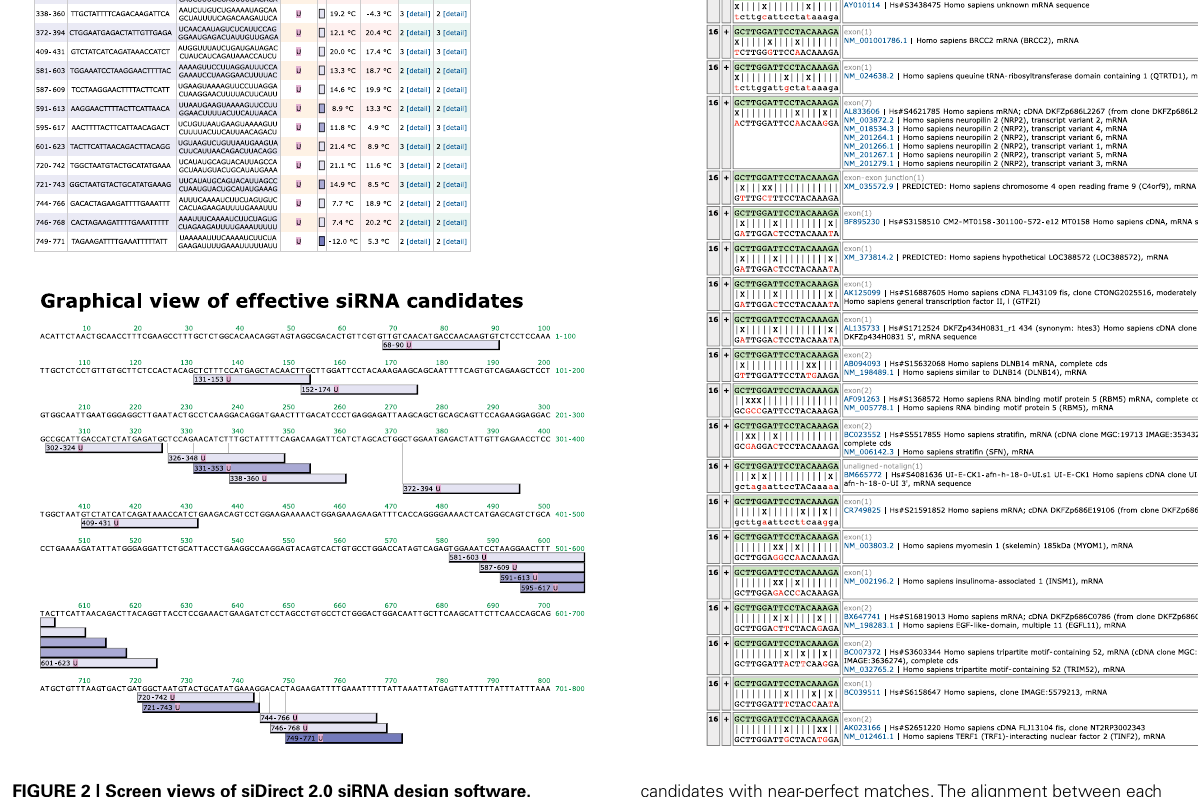
FIGURE 2 | Screen views of siDirect 2.0 siRNA design software. (A) Top page (http://siDirect2.RNAi.jp/). (B) Optional parameters for siRNA design. (C) Result page. (D) Detailed list of off-target